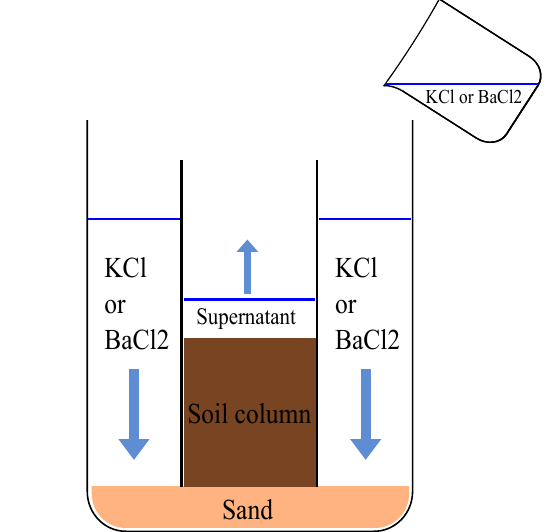
Figure 2. Setup for the KCl or BaCl2 saturation